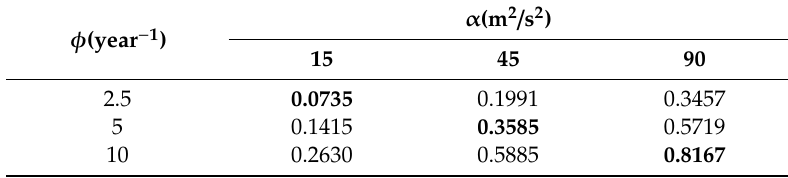
Table 1. Some values of the RI corresponding to nine couples of values ( φ , α ), t = 1 year, and z =